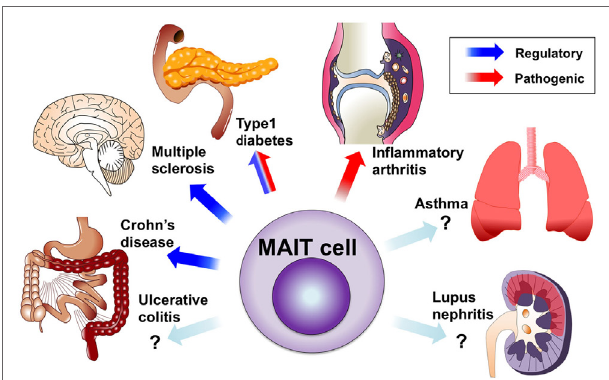
FigURe 2 | Mucosal-associated invariant T (MAIT) cells in autoimmune and immunological diseases. Circulating MAIT cells are reduced in various autoimmune and immunological diseases. MAIT cells are accumulated or present in inflamed tissues, including the central nervous system, intestine, lungs, and joints. The protective roles of MAIT cells were demonstrated in animal models of multiple sclerosis and Crohn’s disease, as well as onset of type 1 diabetes (T1D). The possible contribution of MAIT cells to tissue inflammation was demonstrated in arthritis models and pancreatitis in